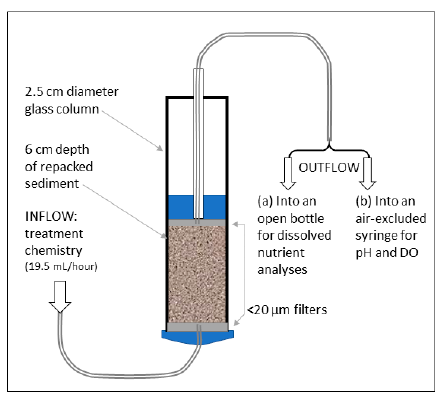
Figure 1. Scematic of one of the column replicates used in the exposure of sediments to solute nutrient treatments simulating saturated benthic conditions.